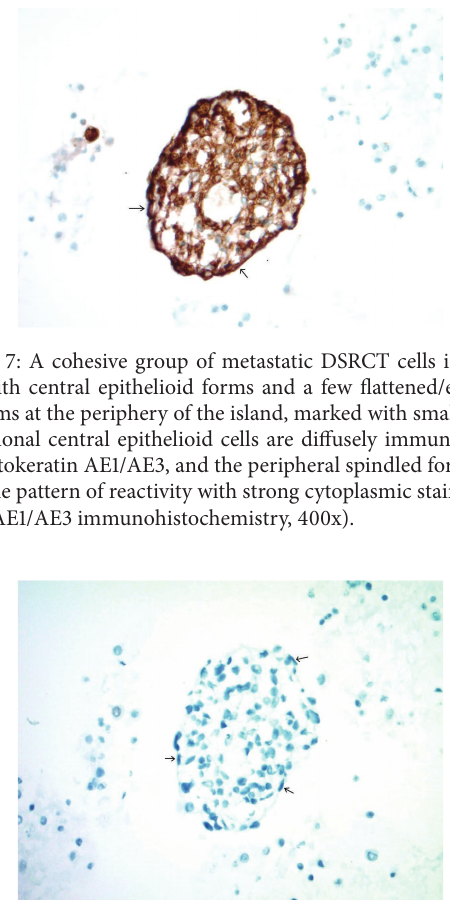
Figure 8: A cohesive group of metastatic DSRCT cells in pleural fluid with central epithelioid forms and a few flattened/elongated cell forms at the periphery of the island, marked by small arrows. The lesional epithelioid cells are nonreactive with smooth muscle actin (SMA), and the peripheral spindled forms show the same pattern of reactivity with no cytoplasmic staining (cell block, SMA immunohistochemistry,